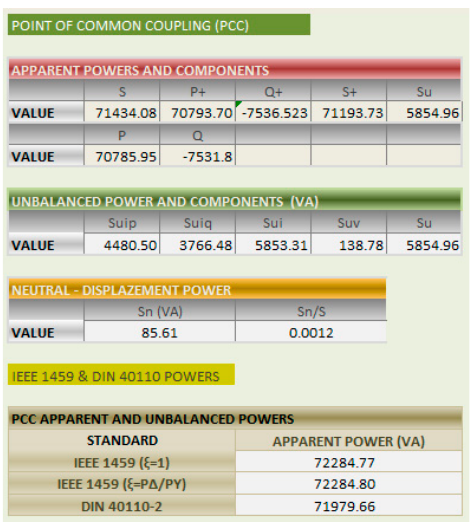
→ → Figure 14. Apparent ( 𝑆⃗ ) and unbalanced ( 𝑆 (cid:3048) (cid:4652)(cid:4652)(cid:4652)(cid:4652)⃗ ) power vectors, neutral-displacement power ( 𝑆 (cid:3041) ), and S ) and unbalanced ( S u ) power vectors, neutral-displacement power ( S n ), and IEEE-1459 and DIN-40110 standards apparent powers calculated by the EPC software in the PCC. Figure 14. Apparent ( Figure 14. Apparent ( 𝑆⃗ ) and unbalanced ( 𝑆 (cid:3048) (cid:4652)(cid:4652)(cid:4652)(cid:4652)⃗ ) power vectors, neutral-displacement power ( 𝑆 (cid:3041) ), and IEEE-1459 and DIN-40110 standards apparent powers calculated by the EPC software in the IEEE-1459 and DIN-40110 standards apparent powers calculated by the EPC software in the PCC.